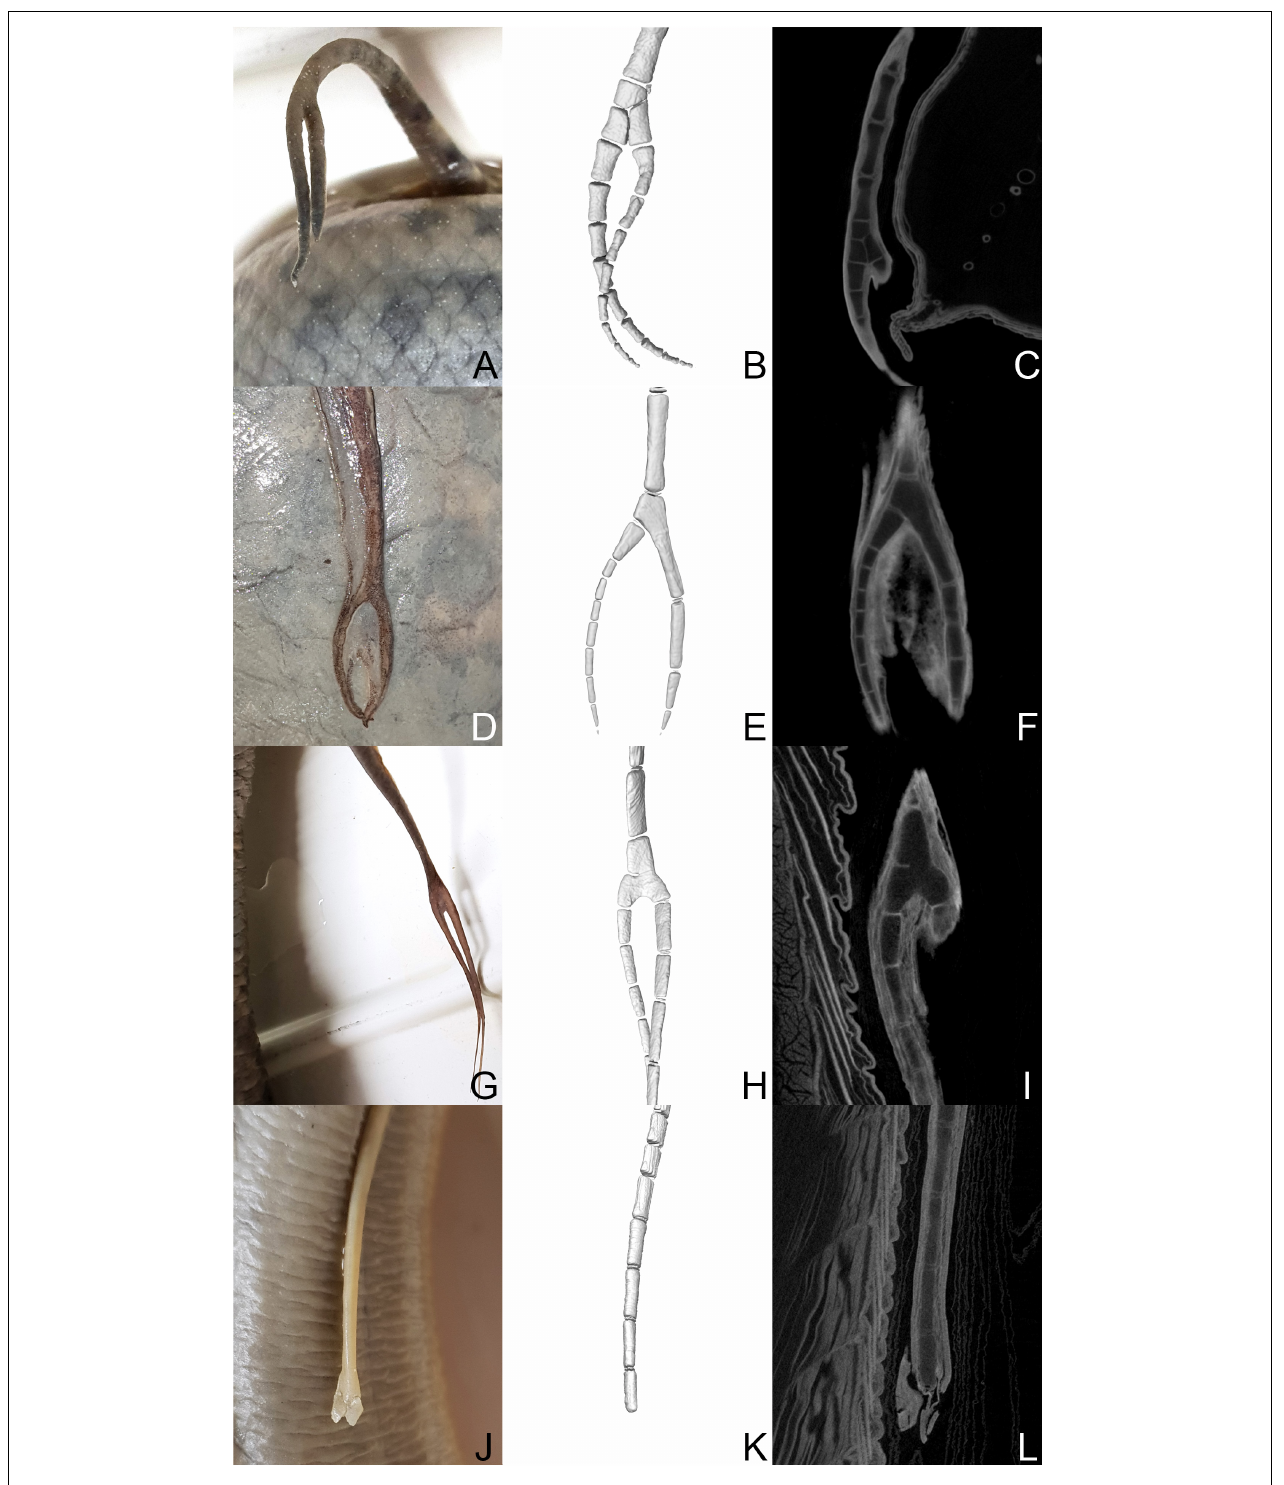
FIGURE 3 | Protopterus annectens spec . (RMCA_Vert_1991.024.P.0001-0002): (A–C) left pelvic fin. Protopterus annectens annectens (RMCA_Vert_1973.015.P.0001): (D–F) left pelvic fin, (G–I) right pectoral fin. Protopterus annectens annectens (RMCA_Vert_P.124855-124859): (J–L) Right pectoral fin. (B,E,H,K) 3D reconstructions of the areas of bifurcation. (C,F,I,L) µ CT scannings of the areas of bifurcation.